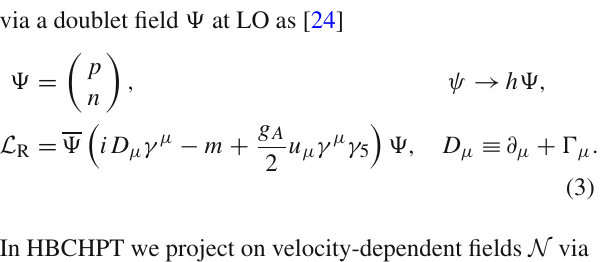
Fig. 1 A pictorial representation of the velocity regions relevant for projection on the nucleon and antinucleon HBCHPT